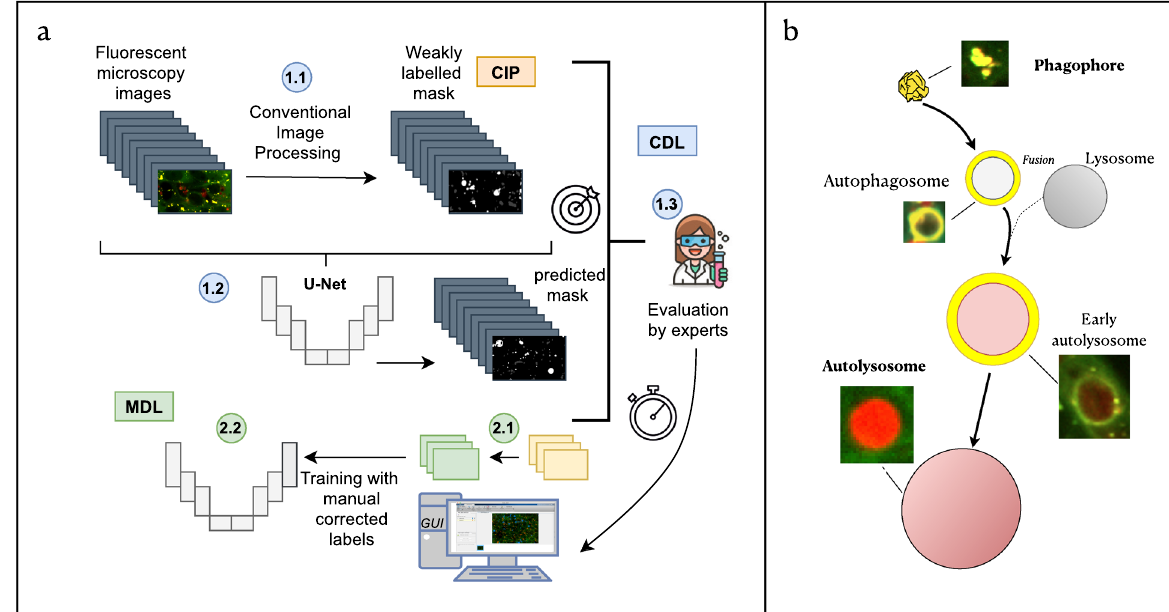
Figure 1. ( a ) General workflow of the proposed pipeline, part 1: (In blue, CIP-based DL: CDL). [1.1] First a weakly labelled dataset is created using conventional imaging processing (CIP). [1.2] After that, a U-net like architecture is trained and [1.3] the accuracy of the evaluated. Including an integration of the trained network in an intuitive tool for biologists that allows easy correction. Proposed pipeline, part 2: (In green, for Manually based DL: MDL). [2.1] Manual corrected masks are easily generated using the GUI, which is employed to train a U-net from scratch [2.2]. ( b ) The biological process of autophagy and its detection with Rosella biosensor. The four main phases are: The initial state - Phagophore, intermediate states - Autophagosome and early autolysosome, and final state - Autolysosome. The fusion with the lysosome during the autophagy process yields a pH decrease which induces a change of colour in the fluorescent microscopy